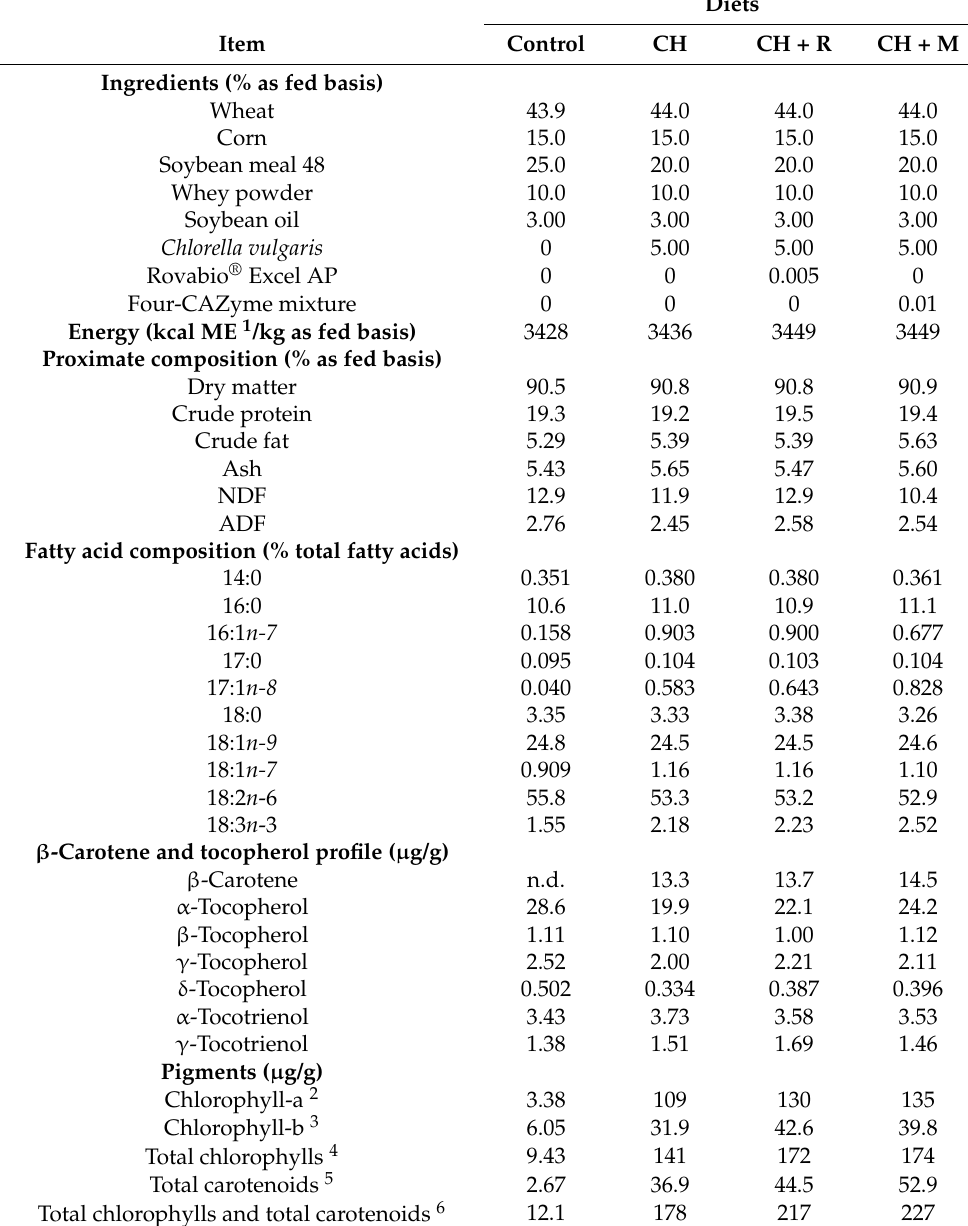
Table 1. Ingredients and chemical composition of experimental